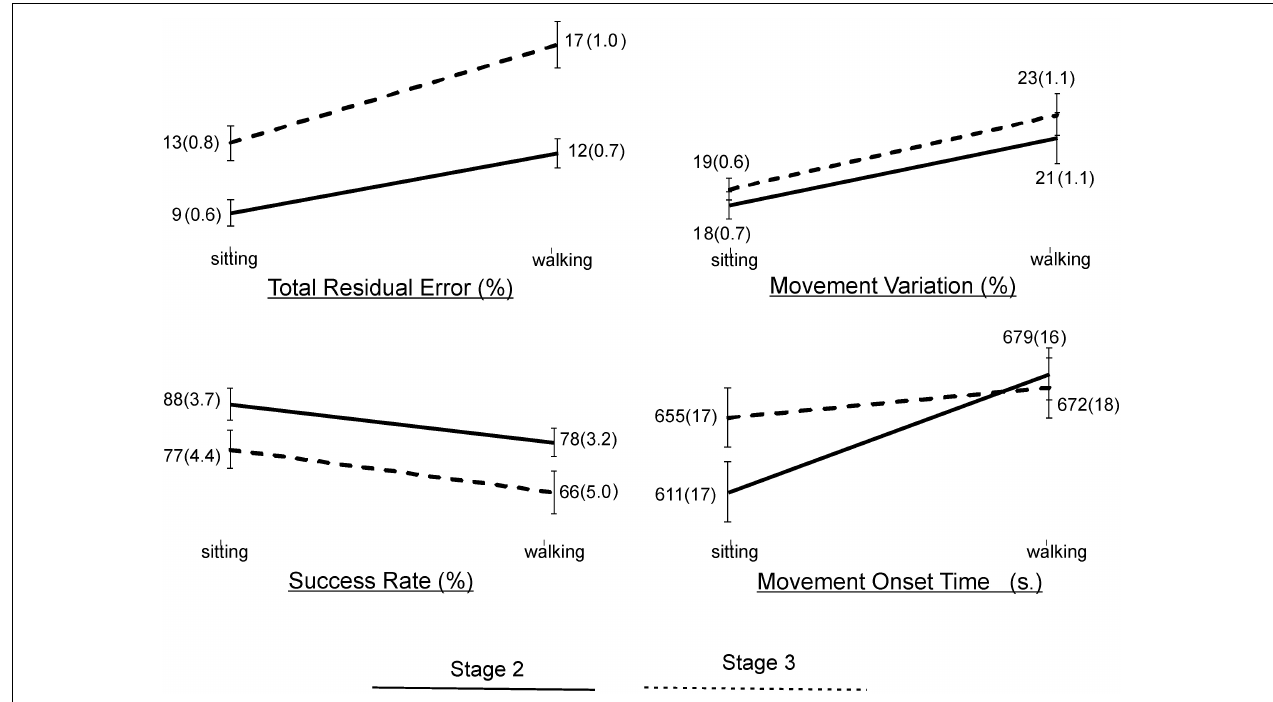
FIGURE 3 | Plots and values of group means and in brackets standard error of mean (SEM) for the VMT and VCG outcome measures by task condition and disease stage.